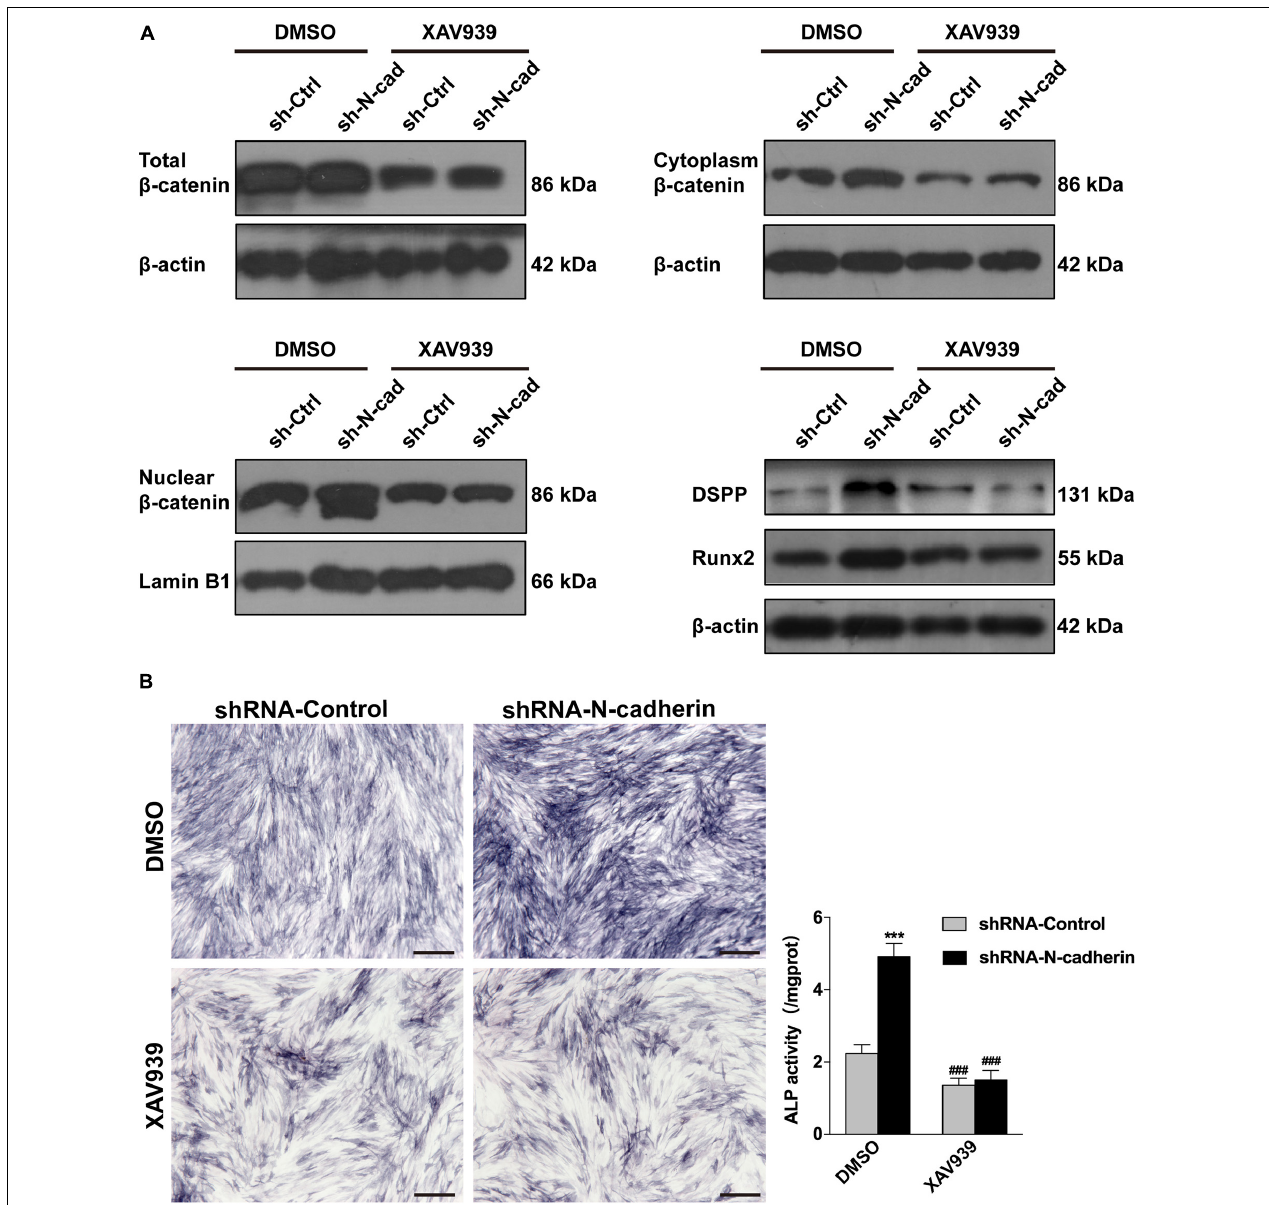
FIGURE 5 | Inhibition of β -catenin by XAV939 reversed the effects of N-cadherin downregulation on dental pulp stem cells (DPSCs) odontogenic differentiation. DPSCs transfected with a control or N-cadherin-specific shRNA lentivirus were subjected to odontogenic induction in the presence or absence of XAV939 (a β -catenin inhibitor). DMSO was used as the vehicle-only control. The expression of nuclear, cytoplasmic, and total β -catenin, and the odontogenic-related genes (DSPP and Runx2), were detected by western blotting on day 14 (A) . The alkaline phosphatase (ALP) activity was measured by ALP staining on day 7 (B) . Scale bars = 500 µ m. Data are presented as the mean ± SEM of three independent experiments. *** P < 0 . 001 compared with the shRNA-Control group, ### P < 0.001 compared with the DMSO